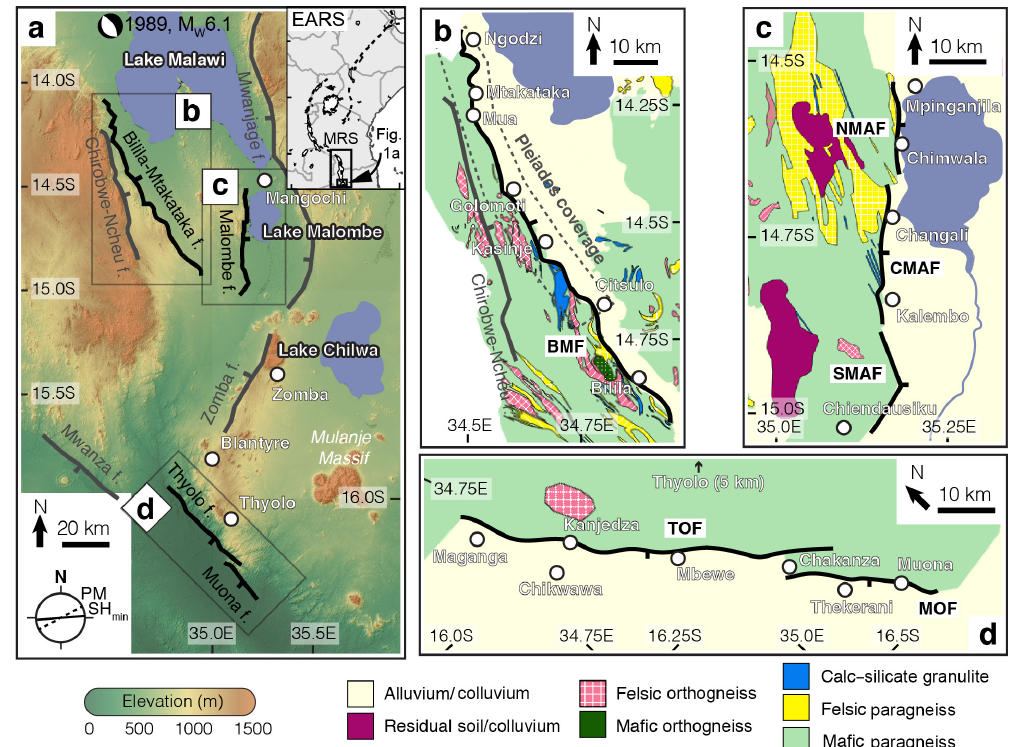
Figure 1. (a) Map of faults in southern Malawi; those used in this study are coloured black. Tick marks show the dip direction. Lower left corner shows the plate motion (PM; 86 ◦ ± 5 ◦ ) from Saria et al. (2014) and local minimum horizontal stress (SH min ; 62 ◦ ) from Delvaux and Barth (2010). Top right corner shows the location with respect to the East African Rift system (EARS) and Malawi Rift system (MRS). Panels (b) – (d) are geological maps of (b) the Bilila–Mtakataka fault (BMF) showing the coverage of the Pleiades satellite imagery (taken from Walshaw, 1965; Dawson and Kirkpatrick, 1968); (c) the Malombe fault (MAF): northern Malombe fault (NMAF), central Malombe fault (CMAF) and southern Malombe fault (SMAF) (taken from Manyozo et al., 1972); and (d) the Thyolo fault (TOF) and Muona fault (MOF) (taken from Habgood et al.,